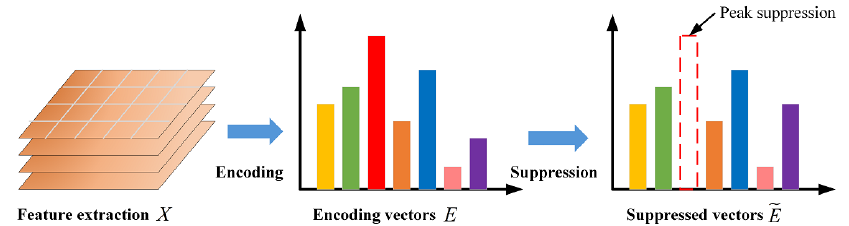
Figure 3. Overview of global orderless feature suppression